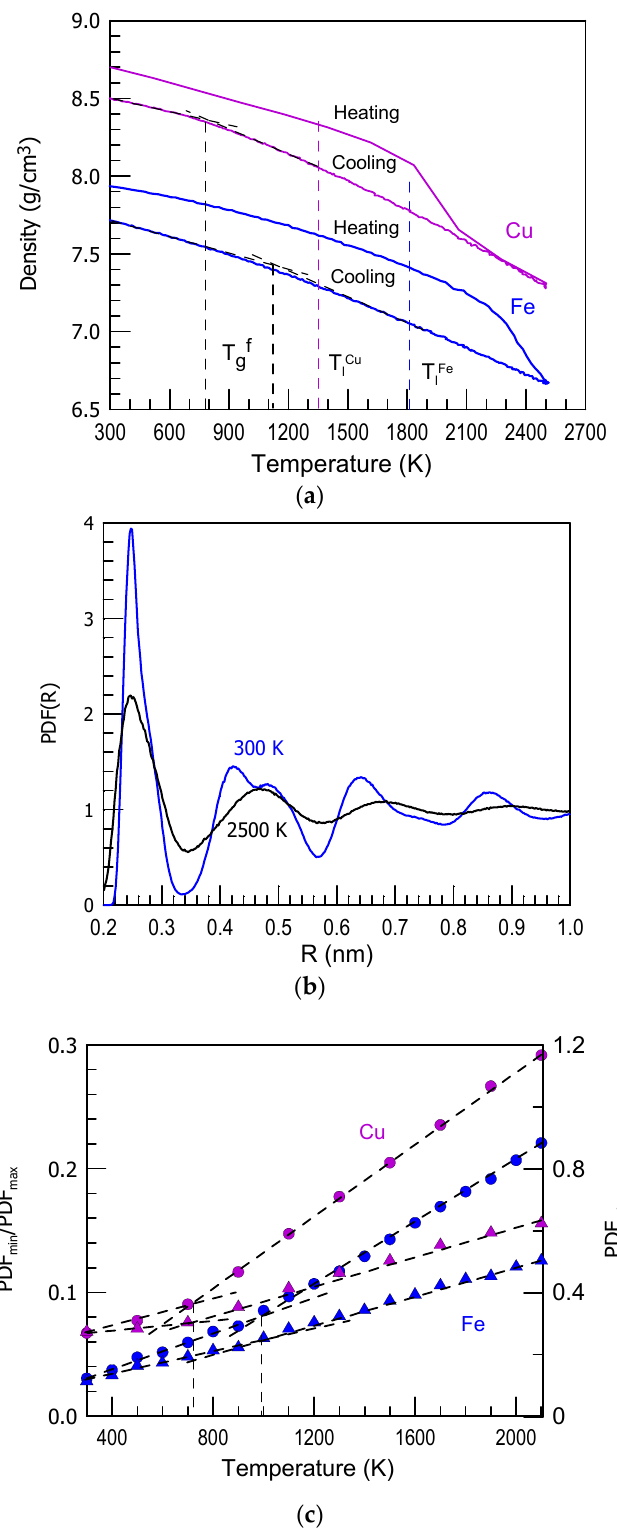
Figure 2. Density changes on heating and cooling of Cu and Fe as a function temperature ( a ). Pair distribution functions (PDFs) of Fe in liquid (2500 K) and glassy (300 K) state ( b ). The values of pair distribution function first minimum PDF min ( • ) and ratios of PDF min / PDF max ( (cid:78) ) ( c ) for Cu (violet) and Fe (blue).